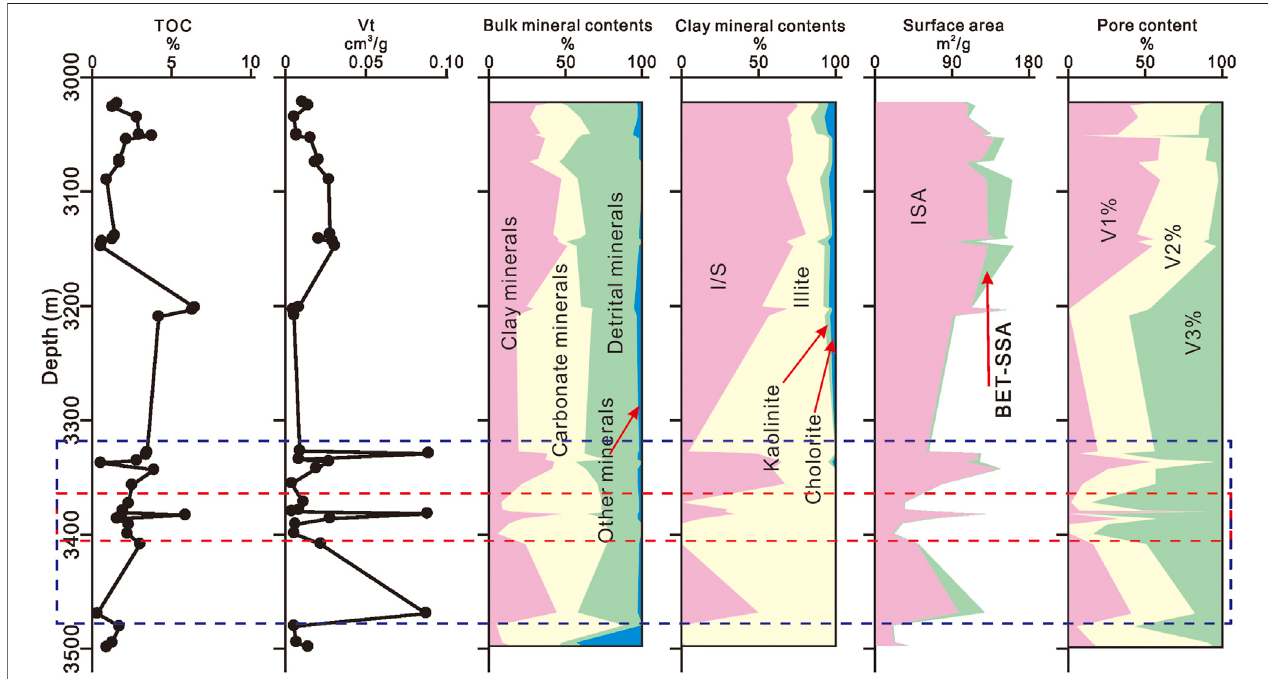
FIGURE 11 | Burial evolution of mineral composition, pores, and surfaces.